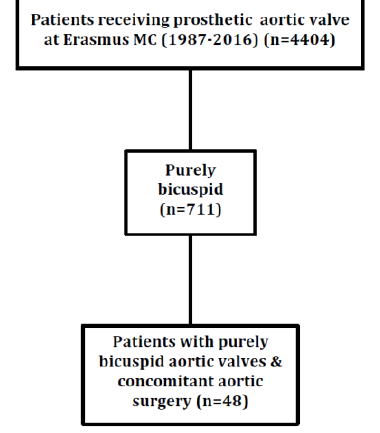
Figure 3. Flowchart of included patients.